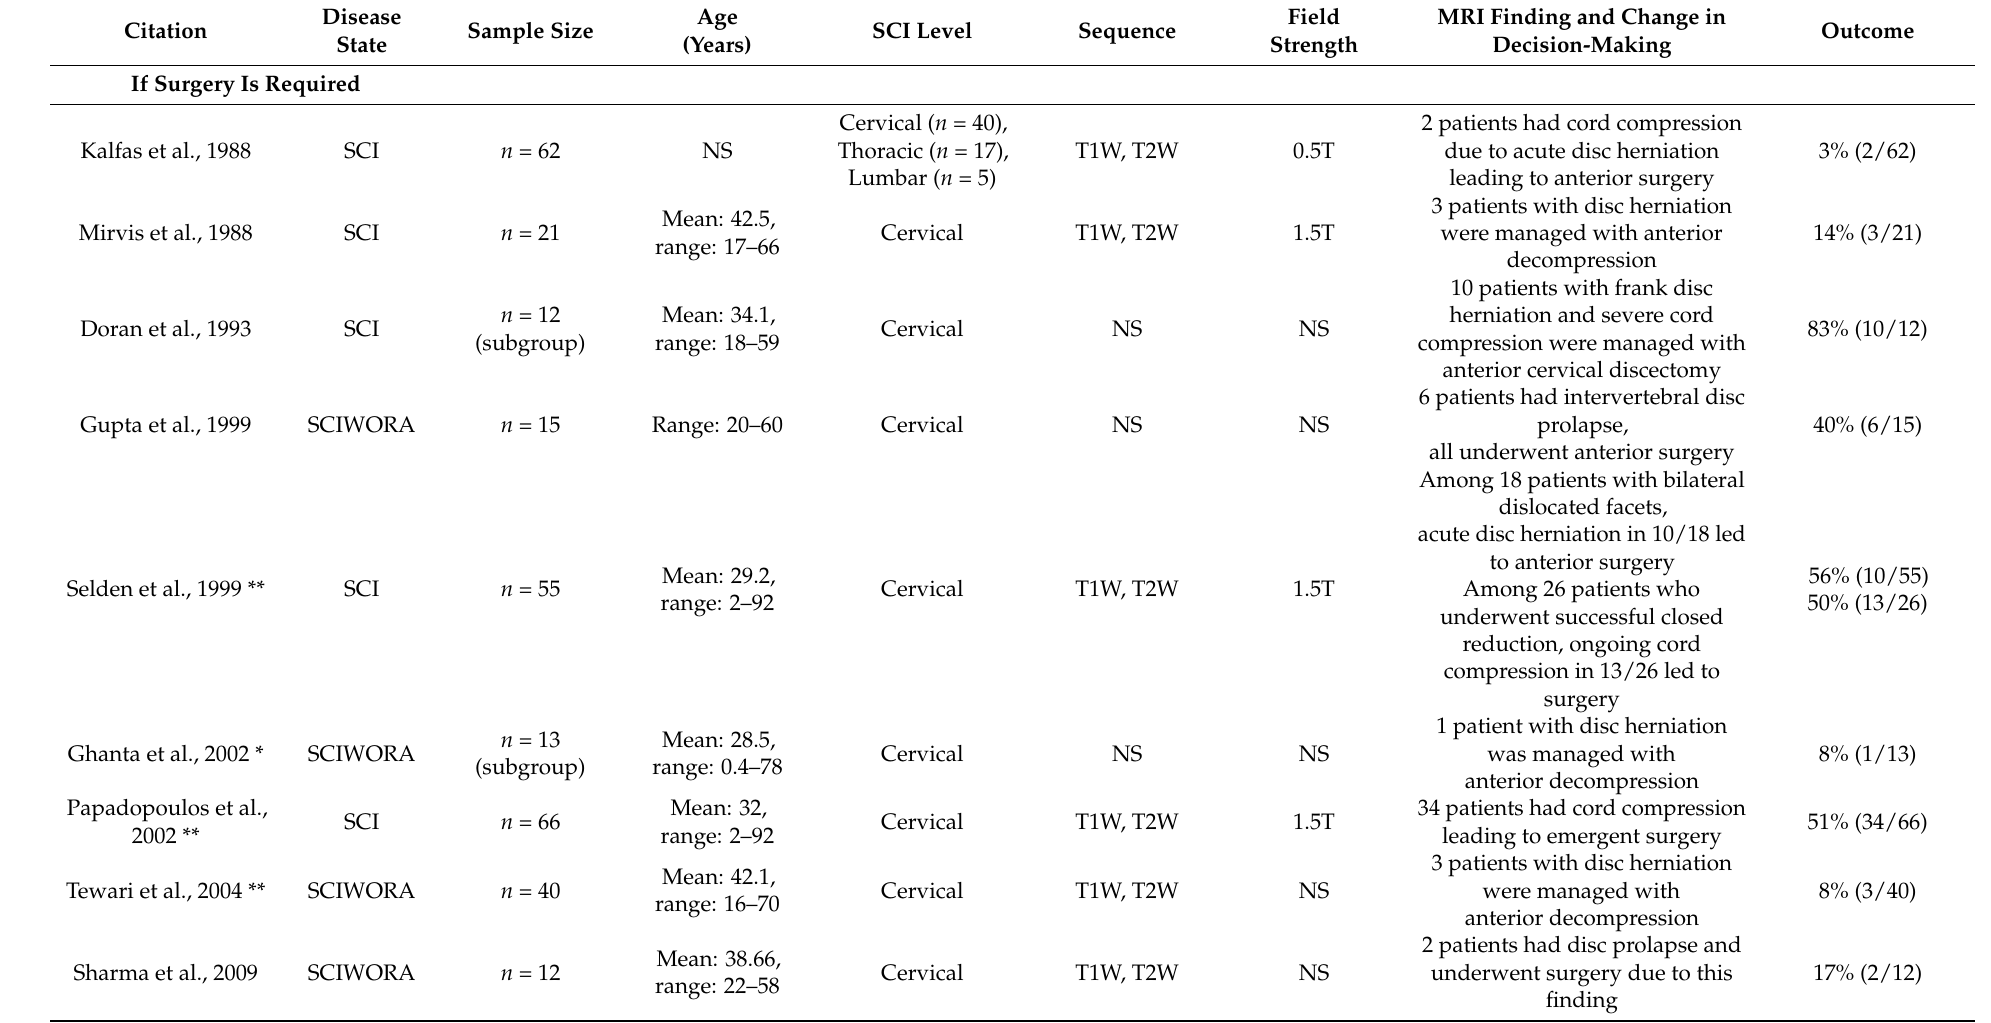
Table 5. Key Question 3: How often does obtaining an MRI alter clinical decision-making in acute